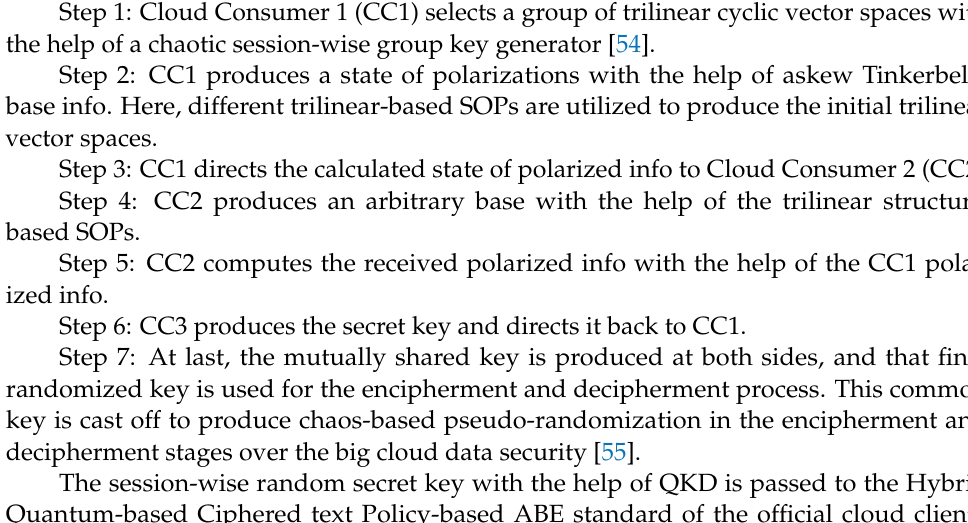
Figure 3. Proposed Polygon Polarization Based QHCP ‐ ABE.